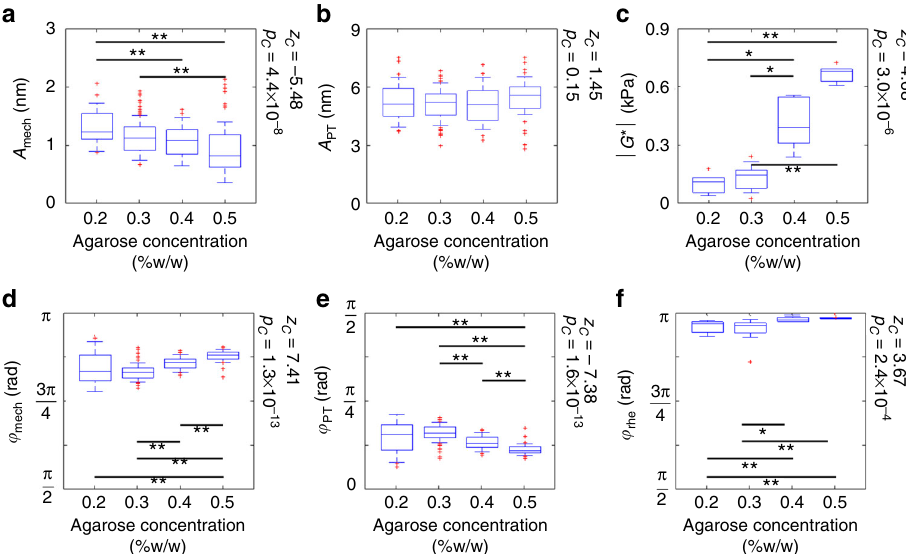
Fig. 5 Box plots comparing the PF-OCE responses in agarose hydrogels to bulk mechanical characterization of the hydrogels by shear rheometry. Magnitude and phase of a , d mechanical response, and b , e photothermal response compared to c , f magnitude and phase of the complex shear modulus measured by parallel-plate shear rheometry. Plotted data from PF-OCE measurements represent median values obtained from each of the 3- μ m beads within the FOV (total of N = 54, 74, 58, and 52 beads for 0.2%, 0.3%, 0.4%, and 0.5% agarose hydrogel samples, respectively). Rheometer measurements were taken on three separate samples, with three repetitions per sample, for each agarose concentration (total of N = 5, 9, 9, and 6 independent measurements of 0.2%, 0.3%, 0.4%, and 0.5% agarose hydrogel samples, respectively). Horizontal lines within boxes indicate median values, boxes denote interquartile ranges. Whiskers on the box plots span one standard deviation; data outside of this range are shown in red markers. Black bar and asterisks indicate a statistically signi fi cant difference between two agarose concentrations per Kruskal – Wallis test at p < 0.05 (*) and p < 0.005 (**) con fi dence levels. z C and p C , respectively, denote normalized test statistic and associated p -value for Cuzick ’ s test for trend across the four agarose concentrations, ordered from 0.2 to 0.5% w/w; thus, z C > 0 indicates an increasing trend while z C < 0 indicates a decreasing trend. A trend was considered statistically signi fi cant if p C < 0.05